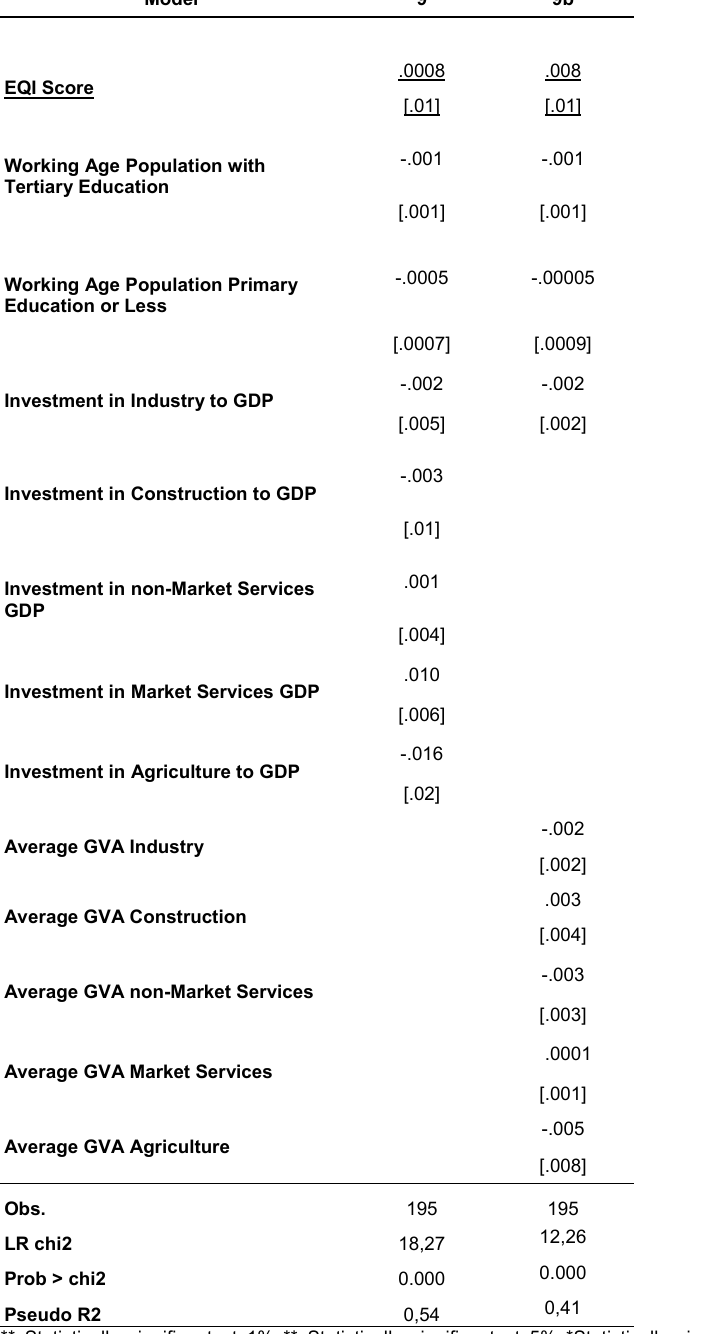
Table 9. Marginal effects on probability Y=1|X. Group E – robustness